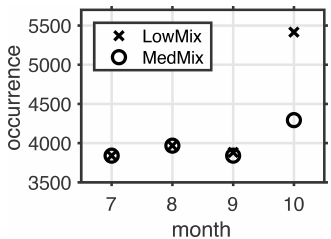
Figure 11. Simulated climatological (2000–2015) occurrence of hypoxia at the monitoring station Buoy 2a . Occurrence refers to the sum of suboxic (i.e., < 120mmolO 2 m − 3 ) model grid boxes, iden- tified in climatological daily model output. From November to June suboxic conditions were absent.